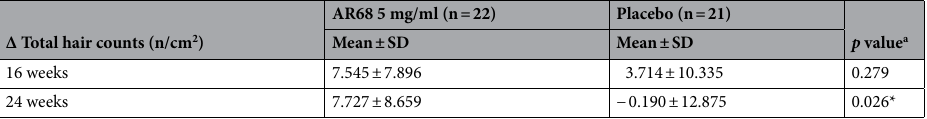
Table 6. Statistical analysis of Δ total hair counts (weeks-Baseline) between SAMiRNA-AR68 5 mg/ml treated and placebo groups. a Significantly different at * p < 0.05 compared with AR68 5 mg/ml treated group and placebo group at same time